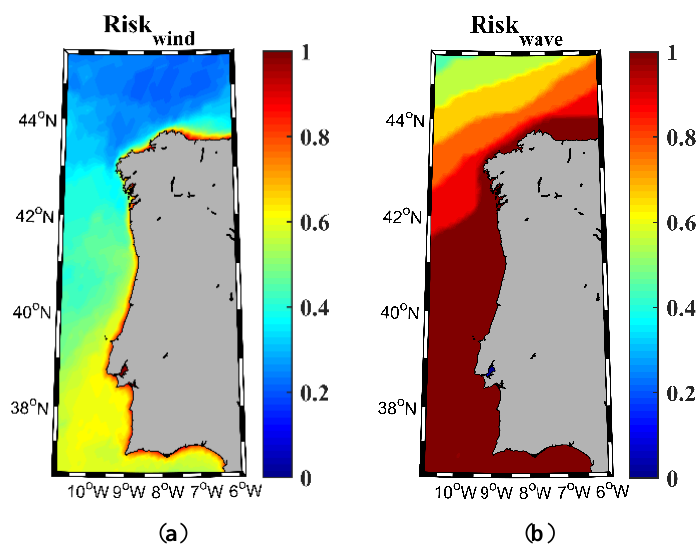
Figure 6. Risk indices for wind ( a ) and wave ( b ) energy resource in the NW Iberian Peninsula for the near future (2026–2045).